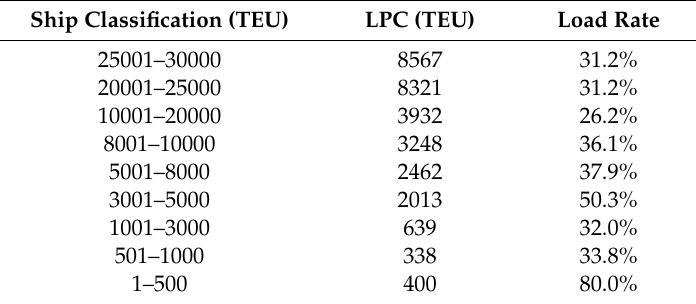
Figure 5. LPC (TEU) Based on Ship Size Classification. Table 13. The Estimation of LPC